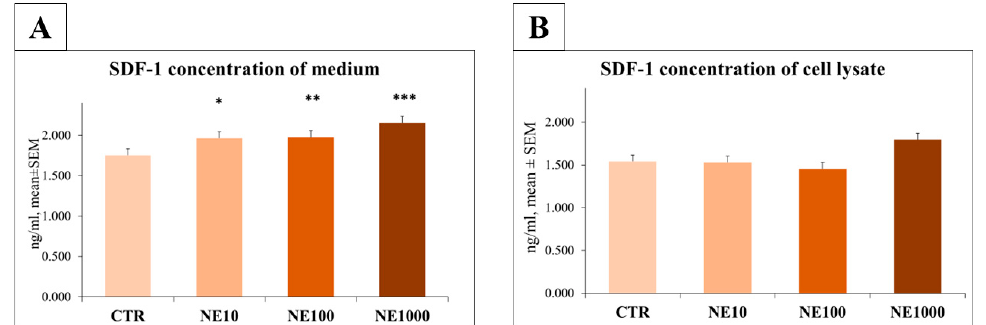
Figure 8. Stromal-cell derived factor-1 (SDF-1) levels in culture media ( A ) and cell lysate ( B ) after 1-h norepinephrine (NE) treatment. CTR = non-treated control cells, NE10 = 10 µM norepinephrine treated cells, NE100 = 100 µM norepinephrine treated cells, NE1000 = 1000 µM norepinephrine treated cells. n = 6/group, results are expressed as mean ± SEM, * p < 0.05, ** p < 0.01, *** p < 0.001.